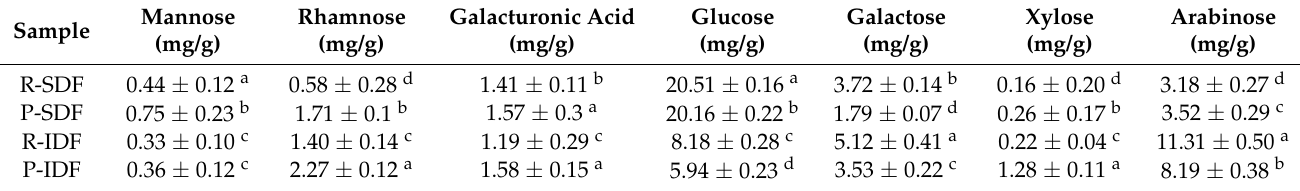
Table 1. The monosaccharide composition of R-SDF, P-SDF, R-IDF and